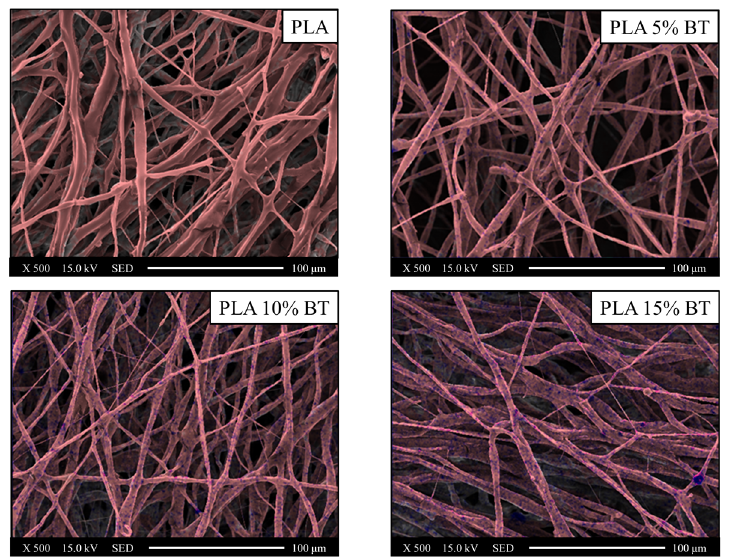
Figure 5. Images collected using EDX elemental maps of the PLA fibers and composites after five minutes of UV/O 3 exposure and converted in two different colors (red for carbon and blue for barium) and overlaid on the SEM images in order to verify the incorporation of barium titanate inside the fibers and the distribution. EDX and SEM images were collected at 500 × magnification.